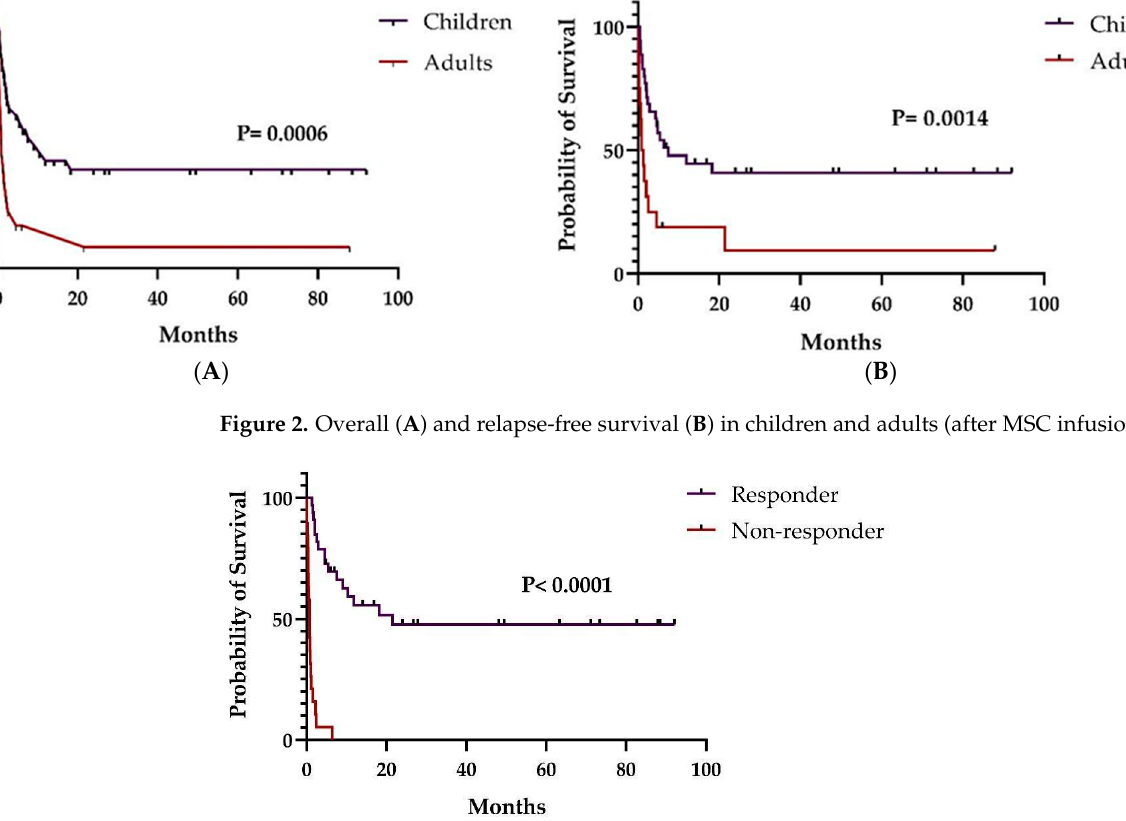
Figure 3. Overall survival according to response (complete and partial) at day 28 after